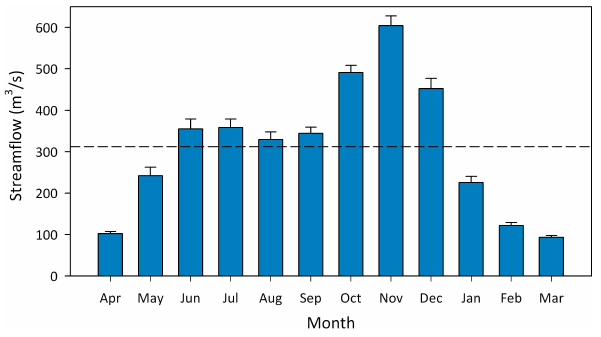
Fig. 2. Mean monthly variations (with standard error bars) of the Neuqu´en River streamflow at the Punta de Indios gauging station (period 1903–2009) over the complete hydrological year (April– March). Dashed line represents the historical mean (312m 3 s − 1 ) for the 1903–2009